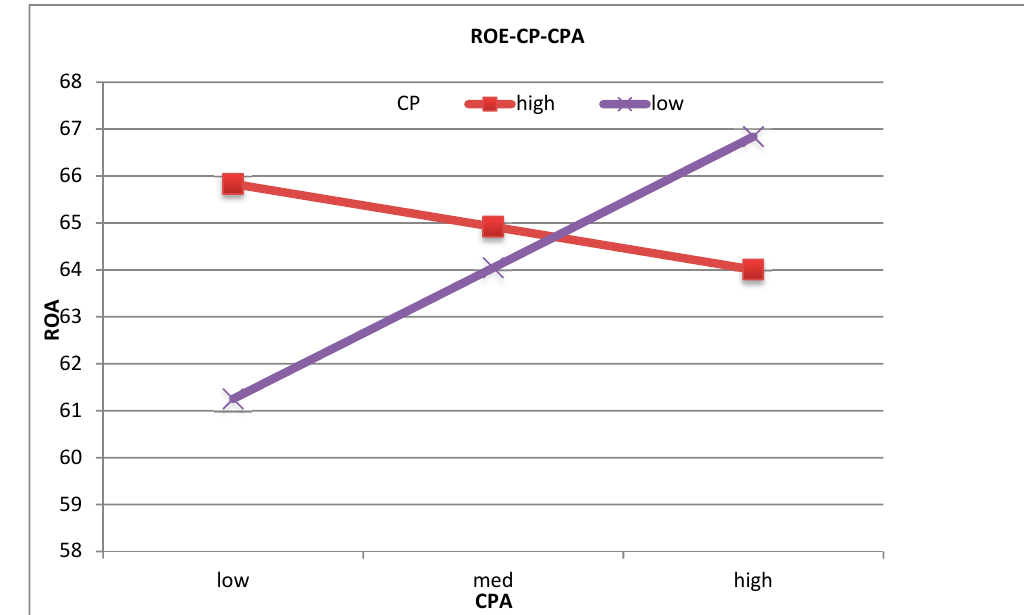
Figure 3. Effects of CPA on ROE: Contingent on CP. Table 6. The Moderating Effect of CP on CPA and Firm Performance (ROE).